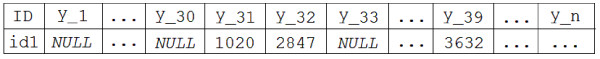


Horizontal spectrum representation. Each row represents a spectrum, where "y-columns" are used to store the y-values for the corresponding "x-coordinates".